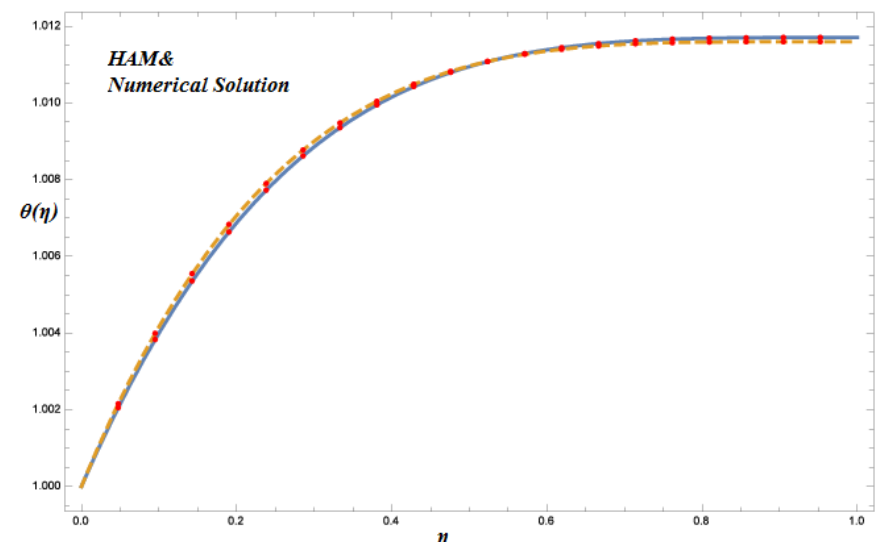
Figure 5. The comparison between HAM and numerical solutions for temperature fields θ ( η ) , when (cid:125) = − 0.45, P r = 10, B r = 0.7, N r = 0.3, D u = 0.3, S c = 0.9, ε = 0.9, S r = 0.1, λ = 0.1, Λ = 0.1, β = 1, S = 0.2.